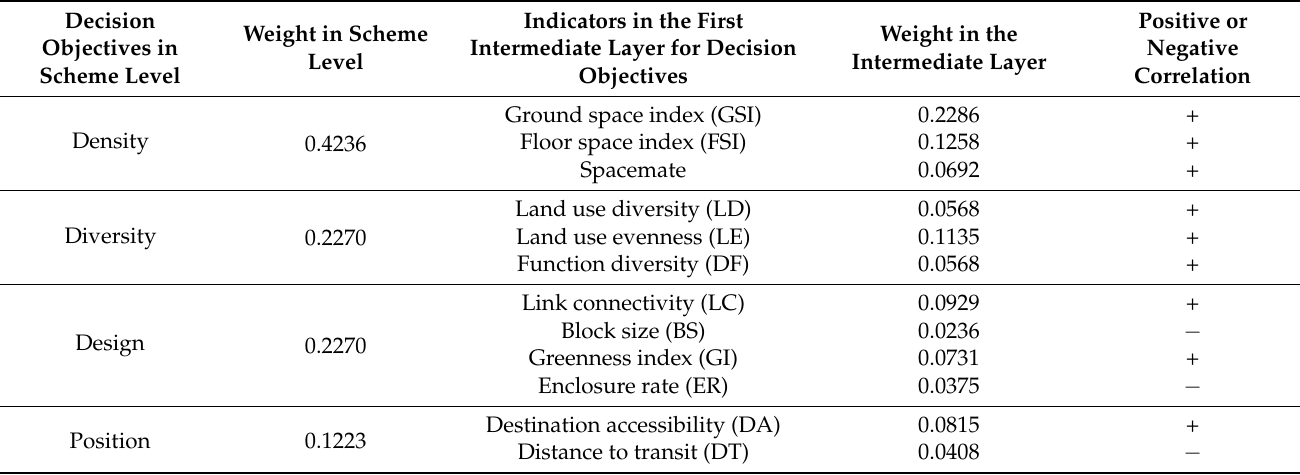
Table 3. AHP assigned weight for urban vitality